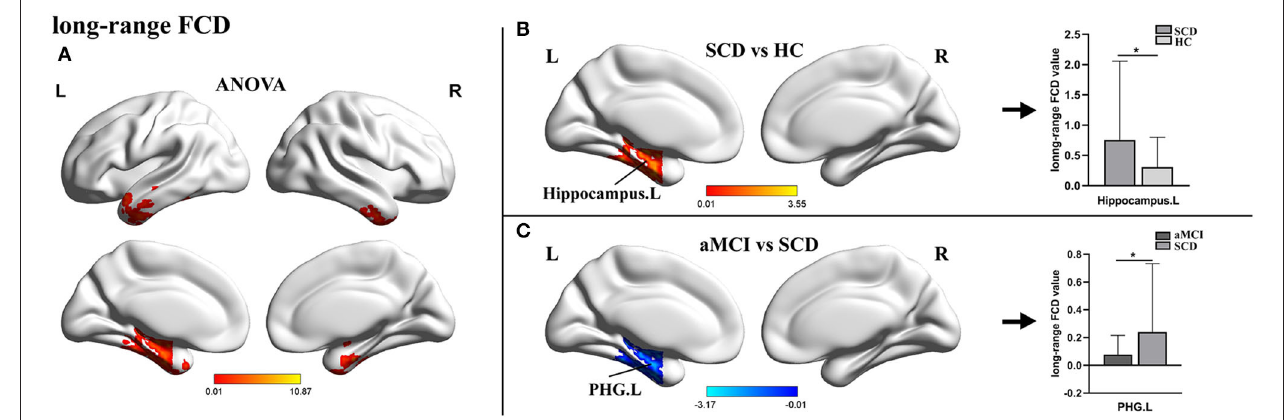
FIGURE 2 | The distribution of brain regions with statistical differences in the long-range FCD for SCD, aMCI, and HC. (A) Shows the results of significant differences in long-range FCD across three groups (one-way ANOCA, p < 0.01, the cluster size > 150 voxels). (B,C) Show the results of the post-hoc analysis across three groups (*TFCE-FWE corrected, p < 0.05, the cluster size > 50 voxels). FCD, functional connectivity density; SCD, subjective cognitive decline; aMCI, amnestic mild cognitive impairment; HC, healthy control; PHG, parahippocampal gyrus; L, left; R, right.